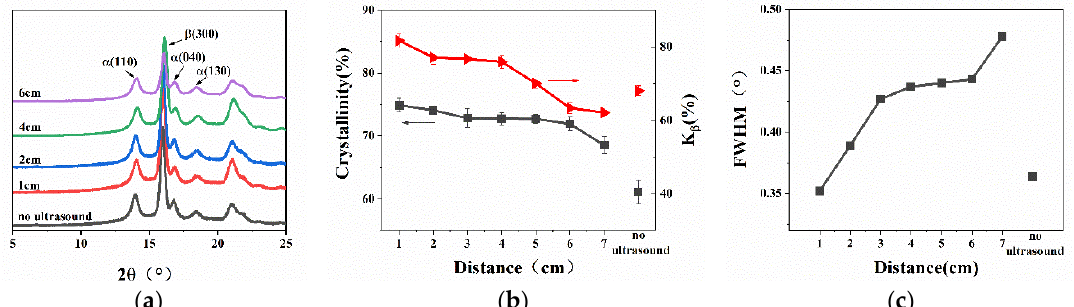
Figure 7. ( a ) Wide-angle X-ray diffraction pattern of WBG-PP prepared at different ultrasound distances. ( b ) Changes in the crystallinity ( w c,x ) and the relative content of β -crystals ( K β ). ( c ) Changes in the full width at half maximum (FWHM) of the β (300) crystal plane.